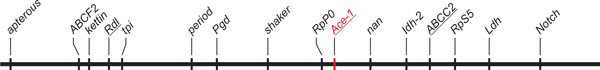
Diagram integrating Ace-1 into a physical map of the codling moth Z chromosome. The gene-based physical map was adopted from Nguyen et al. [26]. The mean relative position of Ace-1 was calculated from physical distances between Ace-1 and RpP0 hybridization signals related to physical distances between RpP0 and Nan in 10 ZZ bivalents. Major genes conferring insecticide resistance are underlined, Ace-1 is in red.